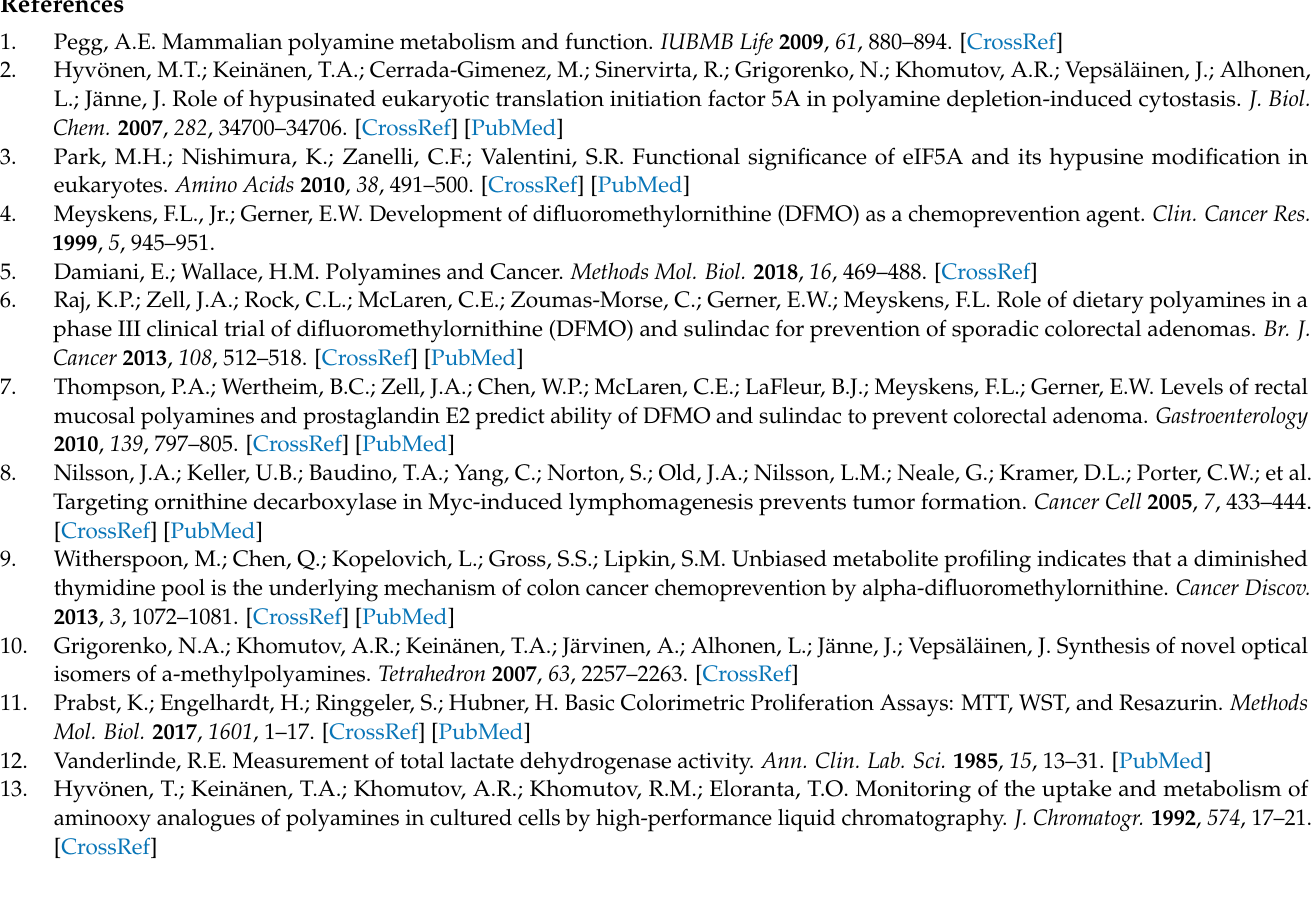
Figure S2. Effect of natural polyamines on the growth of DFMO-treated DU145 cells. Figure S3. Effect of natural polyamines on the growth of SAM-treated DU145 cells. Figure S4. Effect of SAM on the growth and polyamine pools of NIH3T3 and HepG2